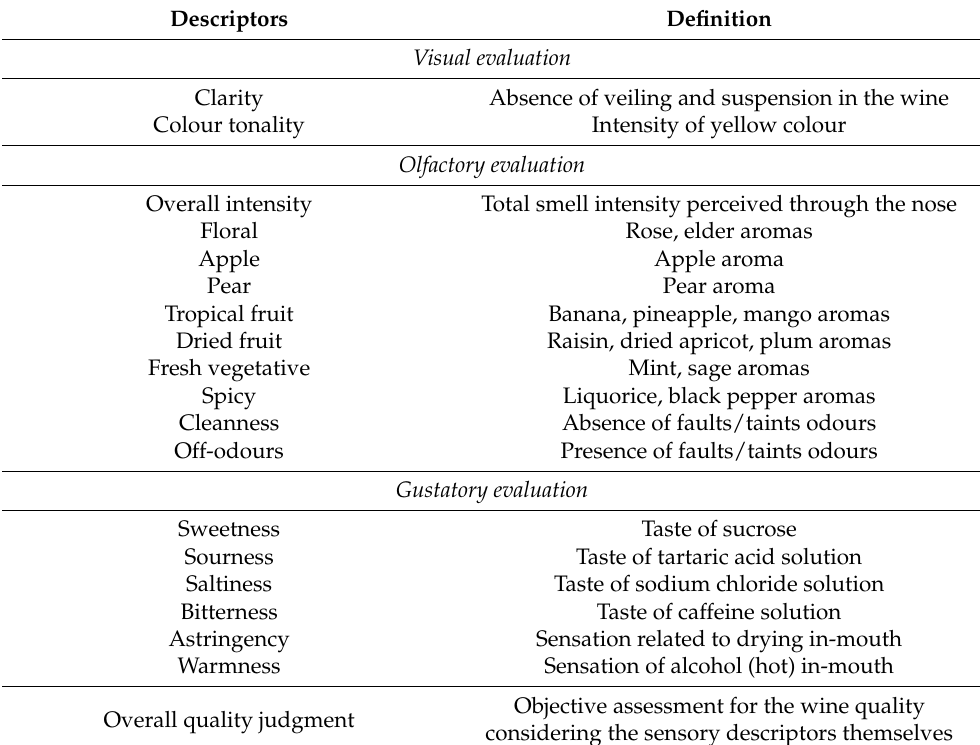
Table 4. List of descriptors and respective definitions used in the sensory